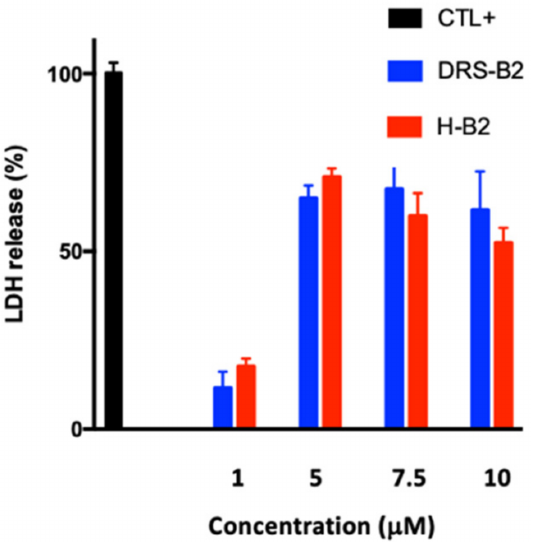
Figure 8. Cytotoxic effect of DRS-B2 on PC3. Twenty-four hours after plating, PC3 cells were single treated with different concentrations of DRS-B2 or H-B2. Triton X100 at 0.9% ( v / v ) was used as an internal positive control. LDH release was measured with a CytoTox 96 kit. Results are expressed in percentage of cytotoxicity versus time of treatment in hours. Results represent the mean ± SEM of three determinations.